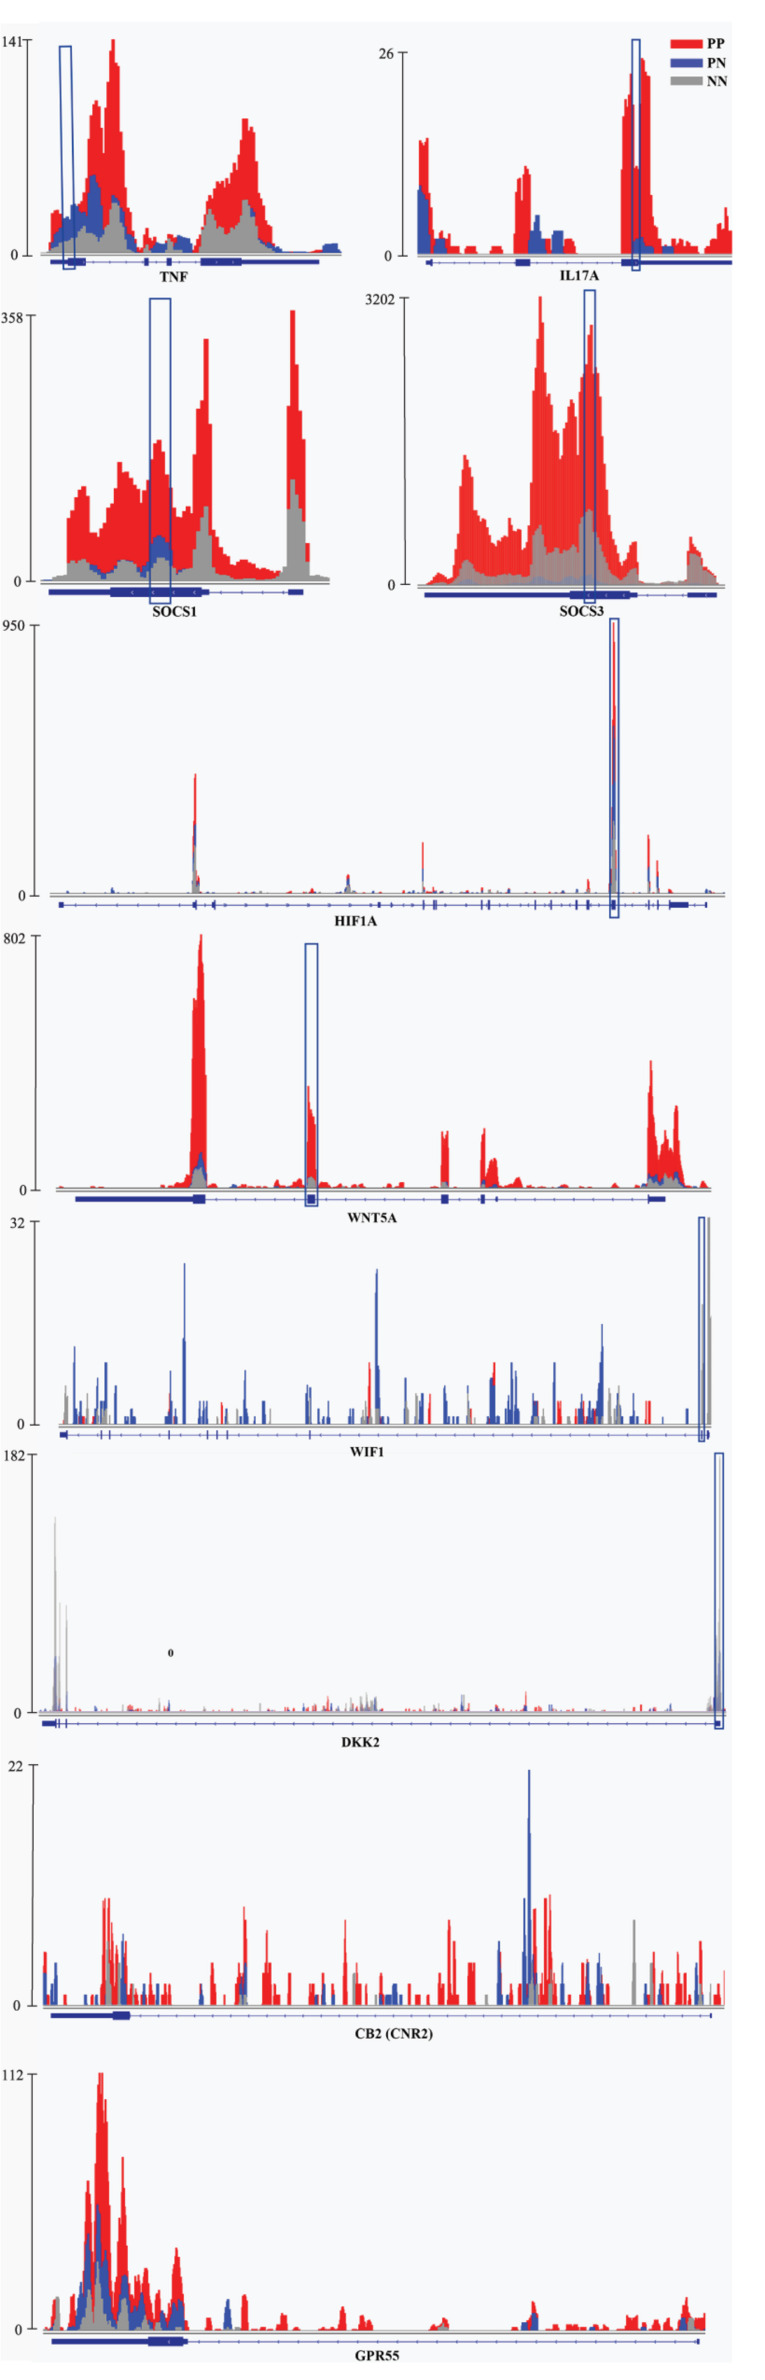
Examples of genes with m6A peaks in PP, PN, and NN. Integrative Genomics Viewer (IGV) tracks showed MeRIP-seq reads distribution in TNF, IL-17A, SOCS1/3, HIF1A, WNT5A, WIF1, DKK2, CNR2, and GPR55 mRNA of PP, PN, and NN. Different colors illustrate the accumulation of m6A-IP reads. The blue squares indicate the verified sequence fragments.